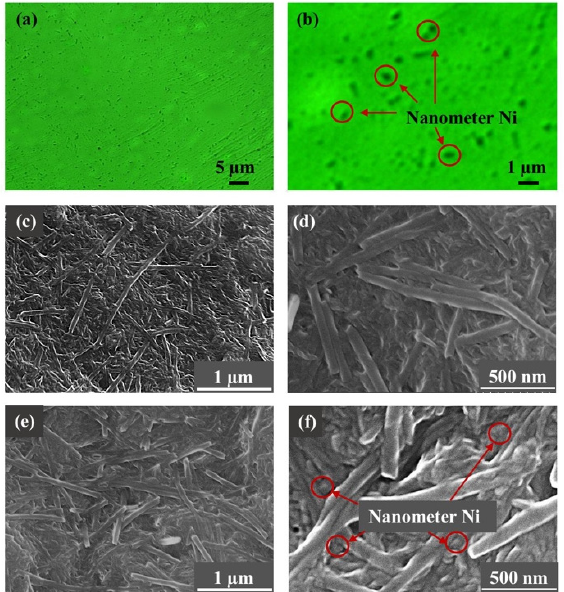
Figure 4. Characterization results of grease sample: ( a , b ) polarizing optical micrograph of 0.2 wt% Ni-doped lithium grease; SEM images of ( c , d ) pure lithium grease and ( e , f ) 0.2 wt% Ni-doped lithium grease.